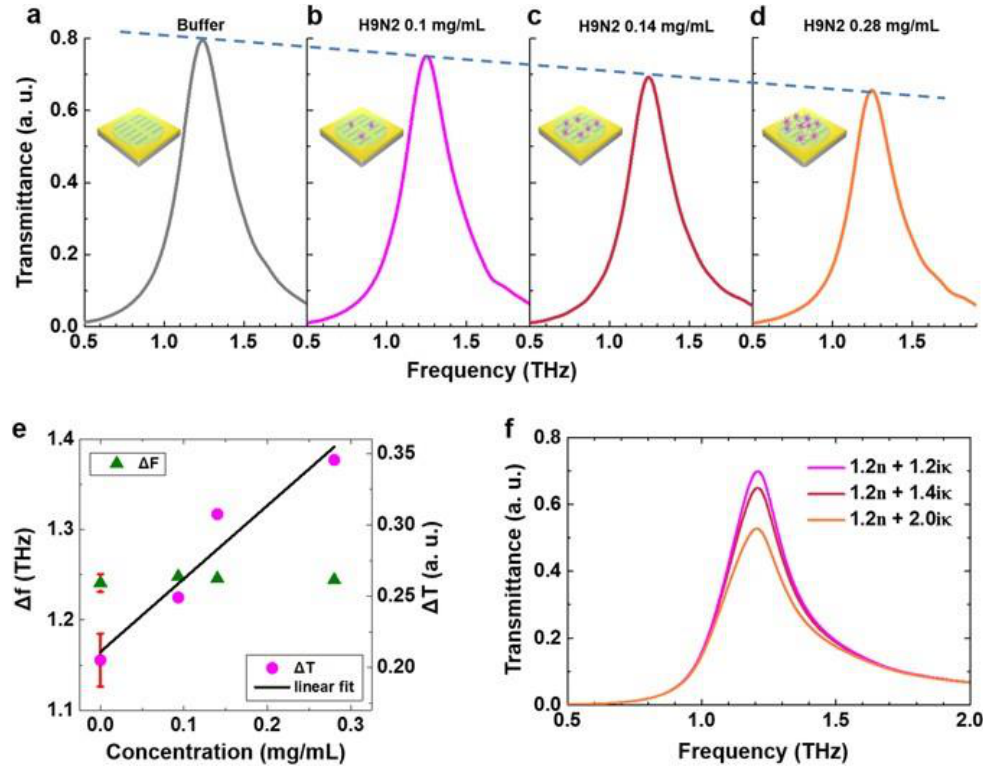
Figure 6 . H9N2 transmittance vs. frequency by varying the viral pathogen concentration. ( a ) Buffer (0 mg mL −1 ), ( b ) 0.10 mg mL − 1 , ( c ) 0.14 mg mL −1 , and ( d ) 0.28 mg mL −1 . ( e ) Variation in the maximum values of the normalized transmittances (ΔT, magenta closed circle) and shifted resonance frequency (Δf, green closed triangle) for the H9N2 virus in different concentrations. The red bar indicates the errors bar due to the buffer solution and the black line is the linear fitting of the transmittance change vs. concentration. ( f ) Results of the numerical simulations using the finite-difference time-domain (FDTD) method of transmittances for three different model samples with various compositions of dielectric constants (n and κ) . Reprinted from [83]..